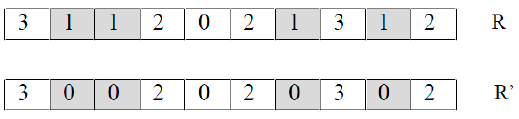
Figure 3. An example of FM.